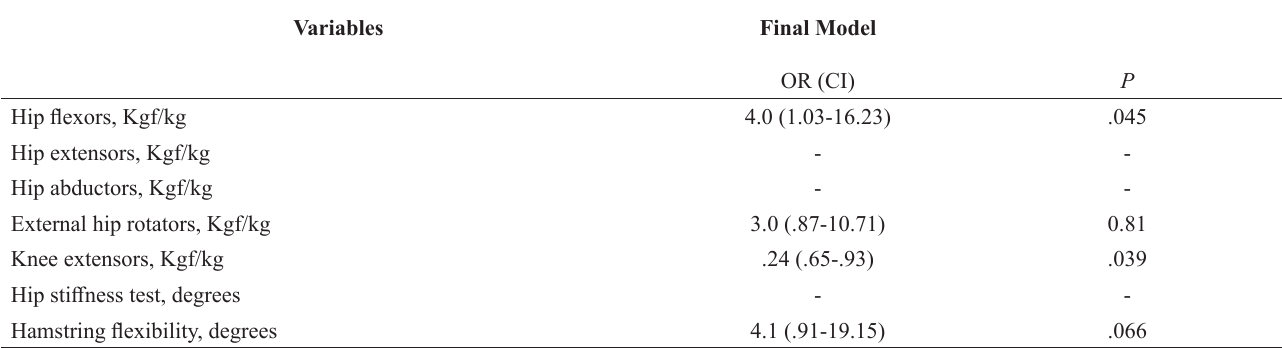
Table 3 - Multivariate binary logistic regression analysis (n=37).